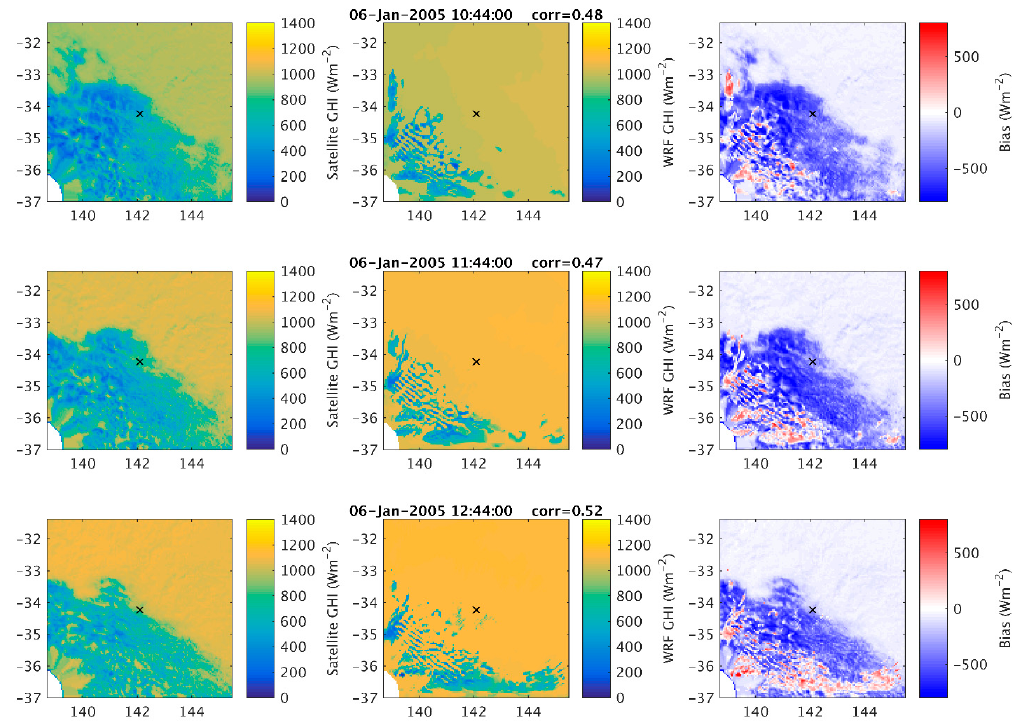
Figure 9. Spatial distribution of GHI observed from the satellite ( left ), simulated by WRF-Solar ( centre ) and the bias ( right ) for intermittent case on 06-Jan at three satellite overpassing times ( top to bottom ).